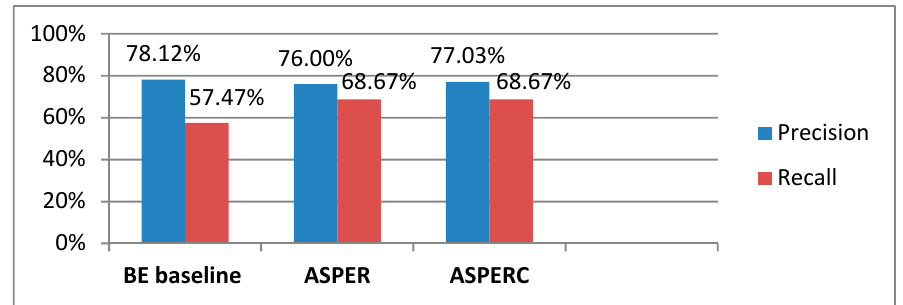
Figure 10. Precision and recall of the ASPER model, ASPERC model, and BE baseline in the restaurant dataset.